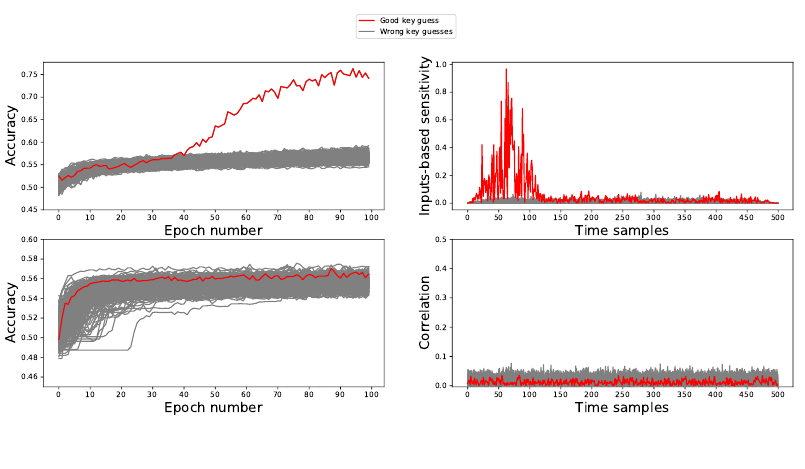
Figure 8: Attack on CW unprotected implementation without de-synchronization. Left: MLP-DDLA accuracies. Center: MLP-DDLA inputs-based sensitivity Right: CPA.